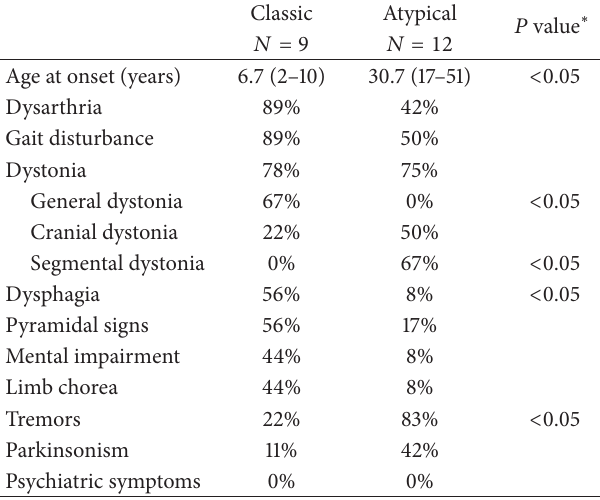
Table 2: Clinical findings in Asian patients: classic versus